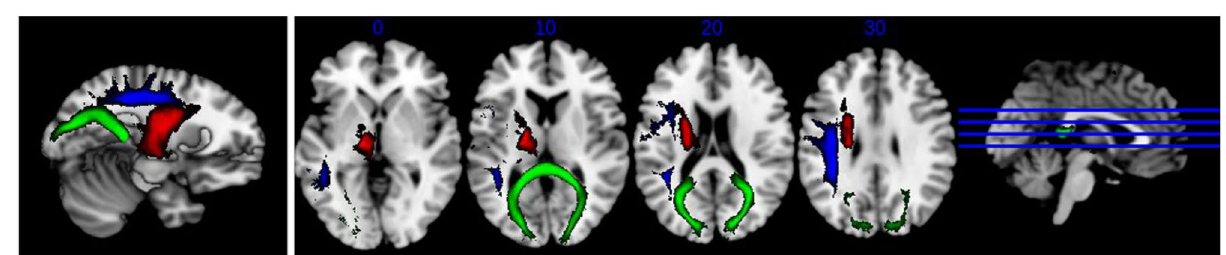
Figure 4. A 3D reconstruction of the three fiber bundles. The red represented the Superior thalamic radiation _L; The blue fiber represented the Superior longitudinal fasciculus_ L; The green represented the Forceps